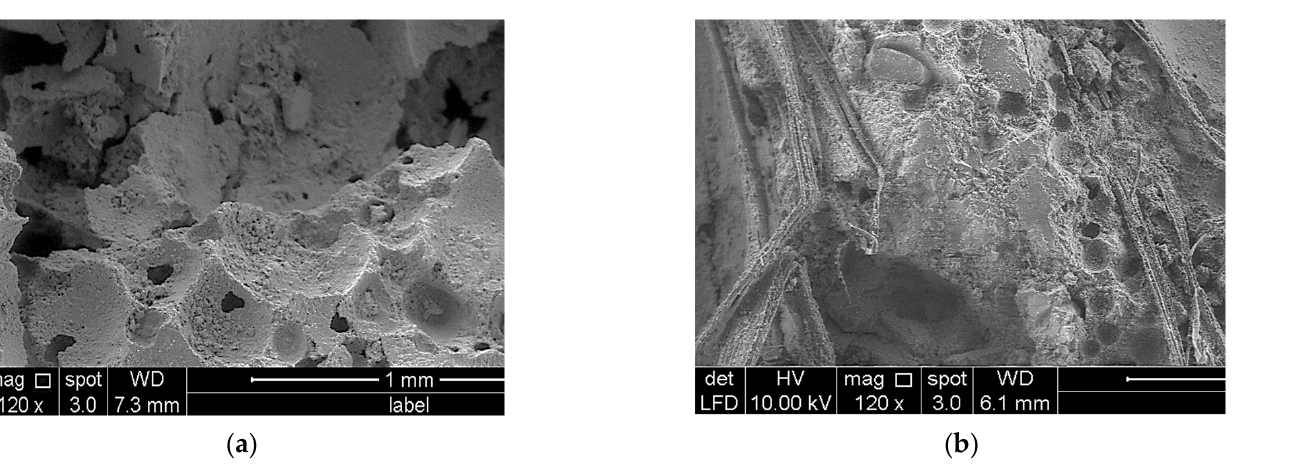
Figure 10. Porosity of foamed concrete with varying percentages of PFF.